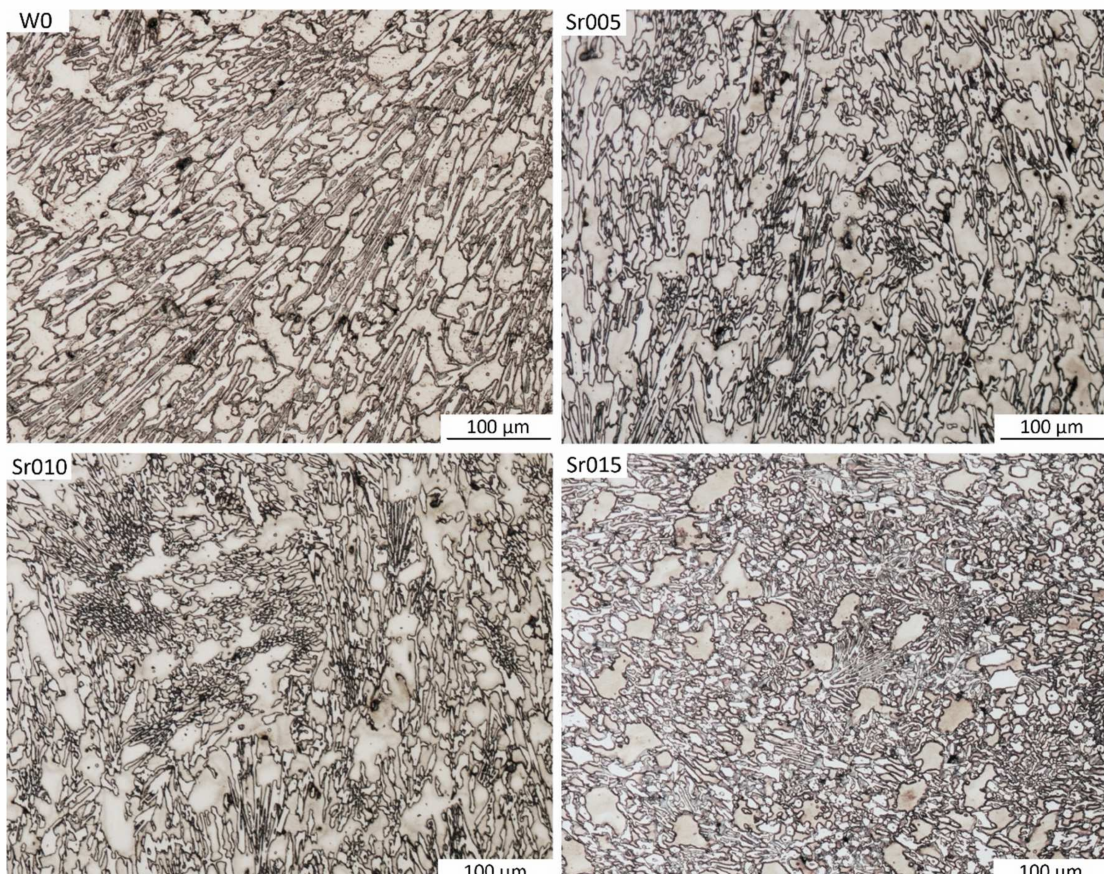
Figure 6. Micrographs from optical microscopy for samples: without strontium addition (W0); with 0.05% of Sr addition (Sr005); with 0.1% of Sr addition (Sr010); with 0.15% of Sr addition